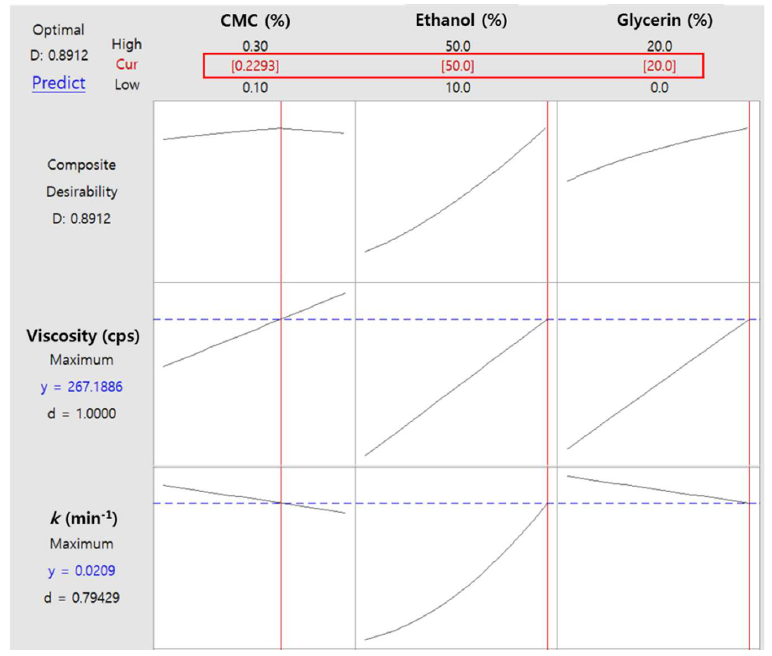
Figure 5. Optimization plots for viscosity and drying rate constant ( k ). The composition of CMC, ethanol, and glycerin exhibiting the maximum composite desirability is presented in the red